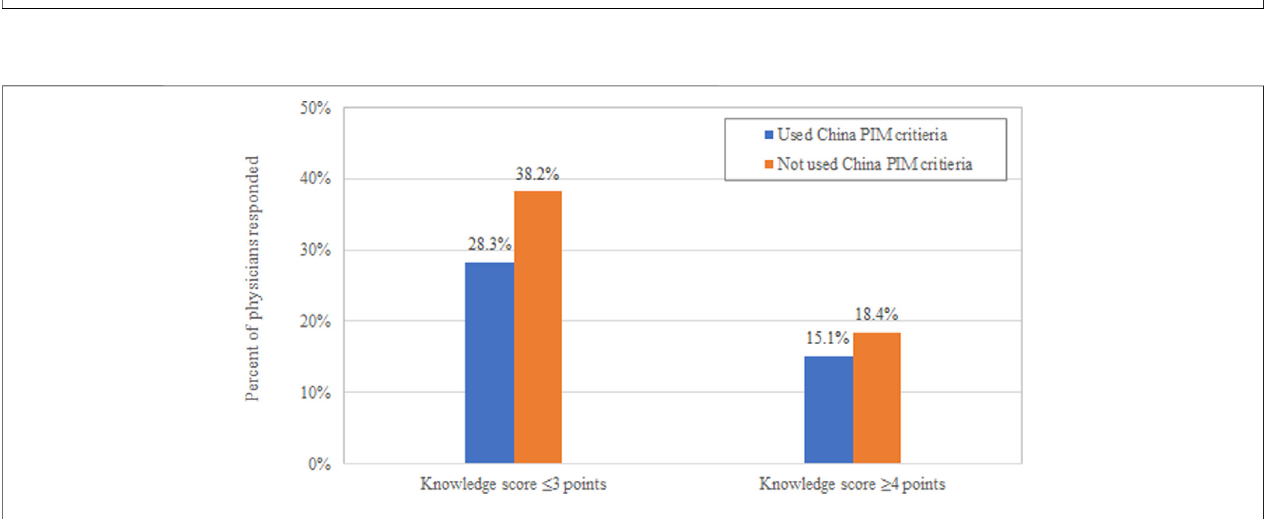
FIGURE 1 | Respondents knowledge of the PIM criteria.